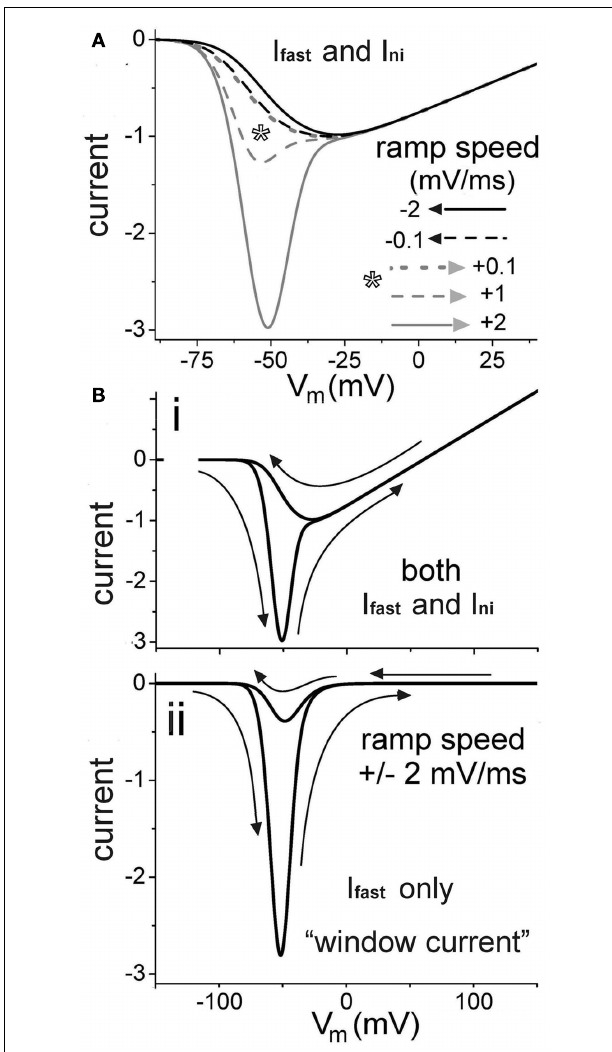
FIGURE 5 | Modeling how to dissect fast and slow I Na using sawtooth hysteresis. (A) For g ni / g Na-fast = 0.0075 (also in B ), total I Na ( V , t ) during negative (black) and positive-going (gray) voltage ramps of various speeds, normalized to peak I Na for the negative 0.1mV/ms ramp. Positive to ∼ − 25mV, all plots overlap. Asterisk: speed range of commonly used depolarizing ramp protocols. (Bi,ii) Current hysteresis (arrows show direction of ramps) during sawtooth ramp clamp, as labeled, for both I Na-fast and I Na-ni [i.e., the total I Na ( V , t ) hysteresis trace as expected in a control experiment] and for I Na-fast only (expected outcome if a drug inhibited I Na-slow and not I Na-fast